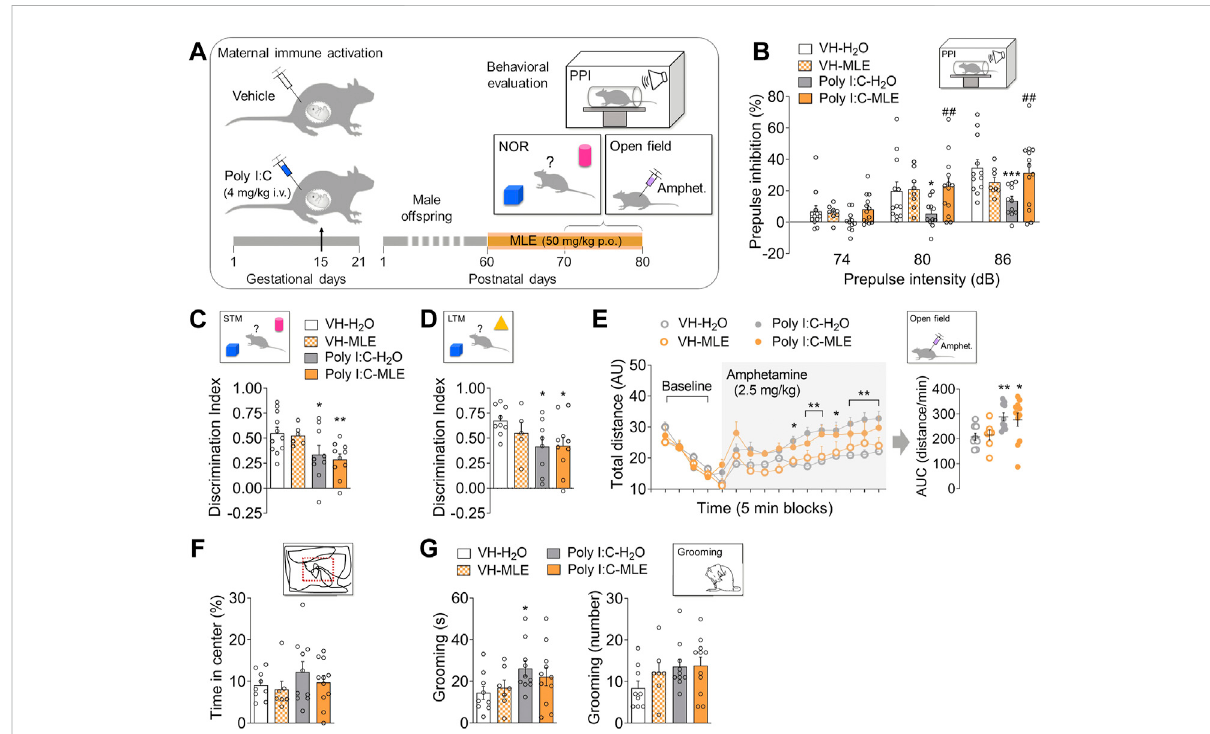
FIGURE 1 The effect of MLE treatment in adulthood on the behavior of the Poly I:C offspring. (A) Experimental timeline showing the design to study the effectofMLEtreatmentinadults.MaternalimmuneactivationwasinducedinpregnantdamsbyadministeringPolyI:C(4 mg/kgi.v.,intravenously)or the vehicle alone(controls) on gestational day (GD) 15. Male offspring were treated orally (p.o.)with MLE at a daily dose of 50 mg/kg of mangiferin in young adults since postnatalday(PND) 60. Then, behavioral evaluation wasperformed (PND70-80). (B) In theprepulseinhibition (PPI) test,the effect ofMLEtreatment inadulthood isrepresented as thepercentage PPI for 74,80 and86 dBprepulseintensity. (C,D) The effect ofMLEtreatment in adulthood on the object discrimination index for the short-term (STM) and long-term memory (LTM) phases of the novel object recognition test (NOR). (E) TheeffectofMLEtreatment inadulthoodonamphetaminesensitivityinthePolyI:Coffspring.Thetotaldistance travelledintheopen fi eld isrepresentedin5 min(min)blocks,beforeandafteramphetamineinjection(shadedarea,2.5 mg/kg,i.p.).Inaddition,theareaunderthecurve(AUC) values ofamphetamine-inducedactivity wererepresented from5 minafter amphetamineinjection. (F) The effectof MLEtreatment inadulthoodon anxiety-likebehavior.Thetime spent (%)inthecenterisrepresentedduring thebaselineperiod offreeexploration intheopen fi eld. (G) Theeffect of MLE treatment in adulthood on grooming behavior. The total time spent grooming and number of grooming events are represented during the last 10 min of the baseline period in the open fi eld. The data are represented as the mean ± SEM of 8 – 13 animals per group in the PPI test, n = 5- 11 animals per group in STM and LTM phases of NOR test, and 9-11 animals per group in amphetamine-induced activity, anxiety-like and grooming behaviors. * p < 0.05, ** p < 0.01, *** p < 0.001 vs. VH-H 2 O; ## p < 0.01 vs. Poly I:C-H 2 O, as assessed by two-way or two-way RM ANOVA followed by the LSD post-hoc